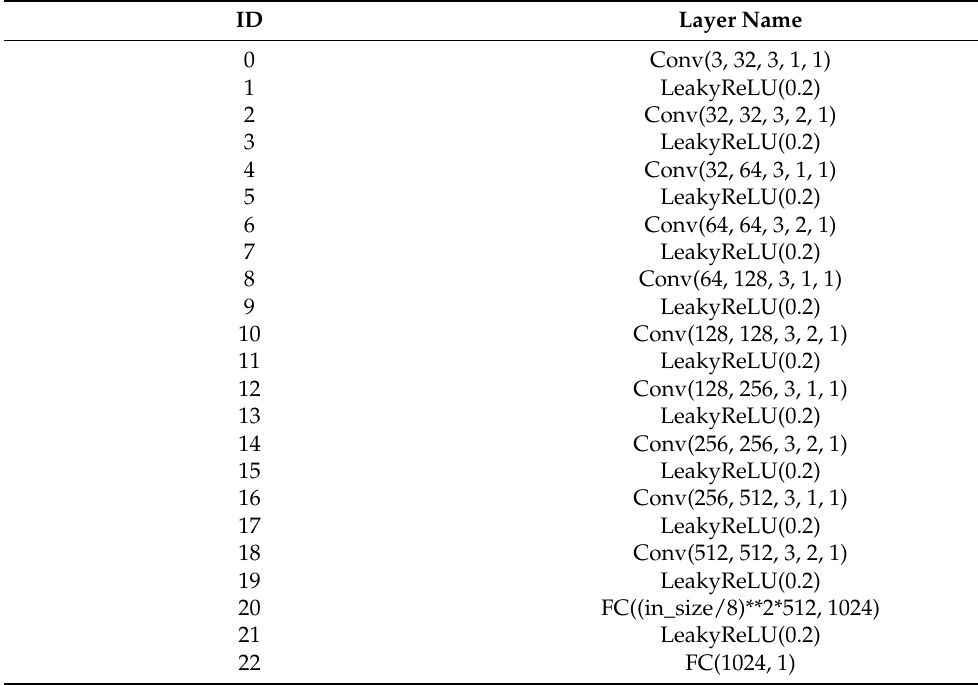
Table A4. The detailed structure of the